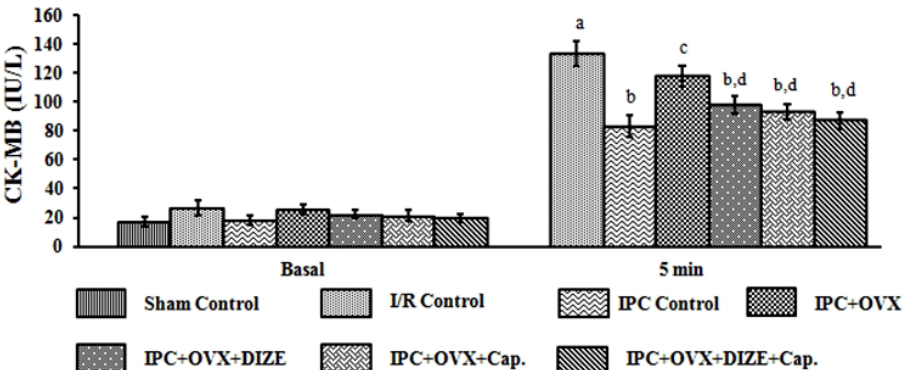
FIGURE 4 - Effect of I/R on the release of CK-MB, effect of ischemic preconditioning (IPC) on the release of CK-MB in normal and OVX rat heart, effect of DIZE perfusion on the release of CK-MB in ovariectomized rat heart and effect of Cap. alone or in combination with DIZE on the release of CK-MB in OVX rat heart. I/R denotes ischemia reperfusion; IPC denotes ischemic preconditioning; OVX denotes ovariectomy; DIZE denotes diminazene aceturate; Cap. denotes captopril. Values are expressed as mean ± S.D, a = p< 0.05 vs. Sham control; b = p< 0.05 vs. I/R control; c = P< 0.05 vs. IPC in normal rat heart; d = p< 0.05 vs. IPC in OVX rat